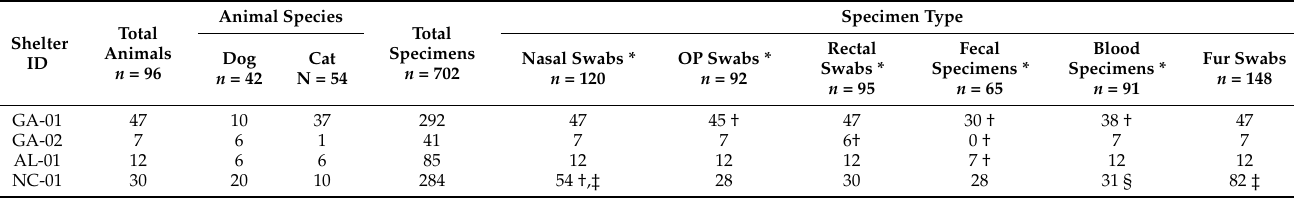
* Diagnostic specimens for laboratory confirmation of SARS-CoV-2 infection include nasal, oral and rectal swabs and fecal specimens tested by SARS-CoV-2 rRT-PCR and blood/sera specimens tested by SARS-CoV-2 virus neutralization. † Not all specimen types were able to be collected from all animals due to reasons including demeanor of the animal or unavailability (in the case of fecal specimens). ‡ In the NC shelter investigation, nasal and fur swabs were collected in duplicate. § In the one seropositive dog in the NC shelter investigation, a second blood specimen was collected two weeks after the